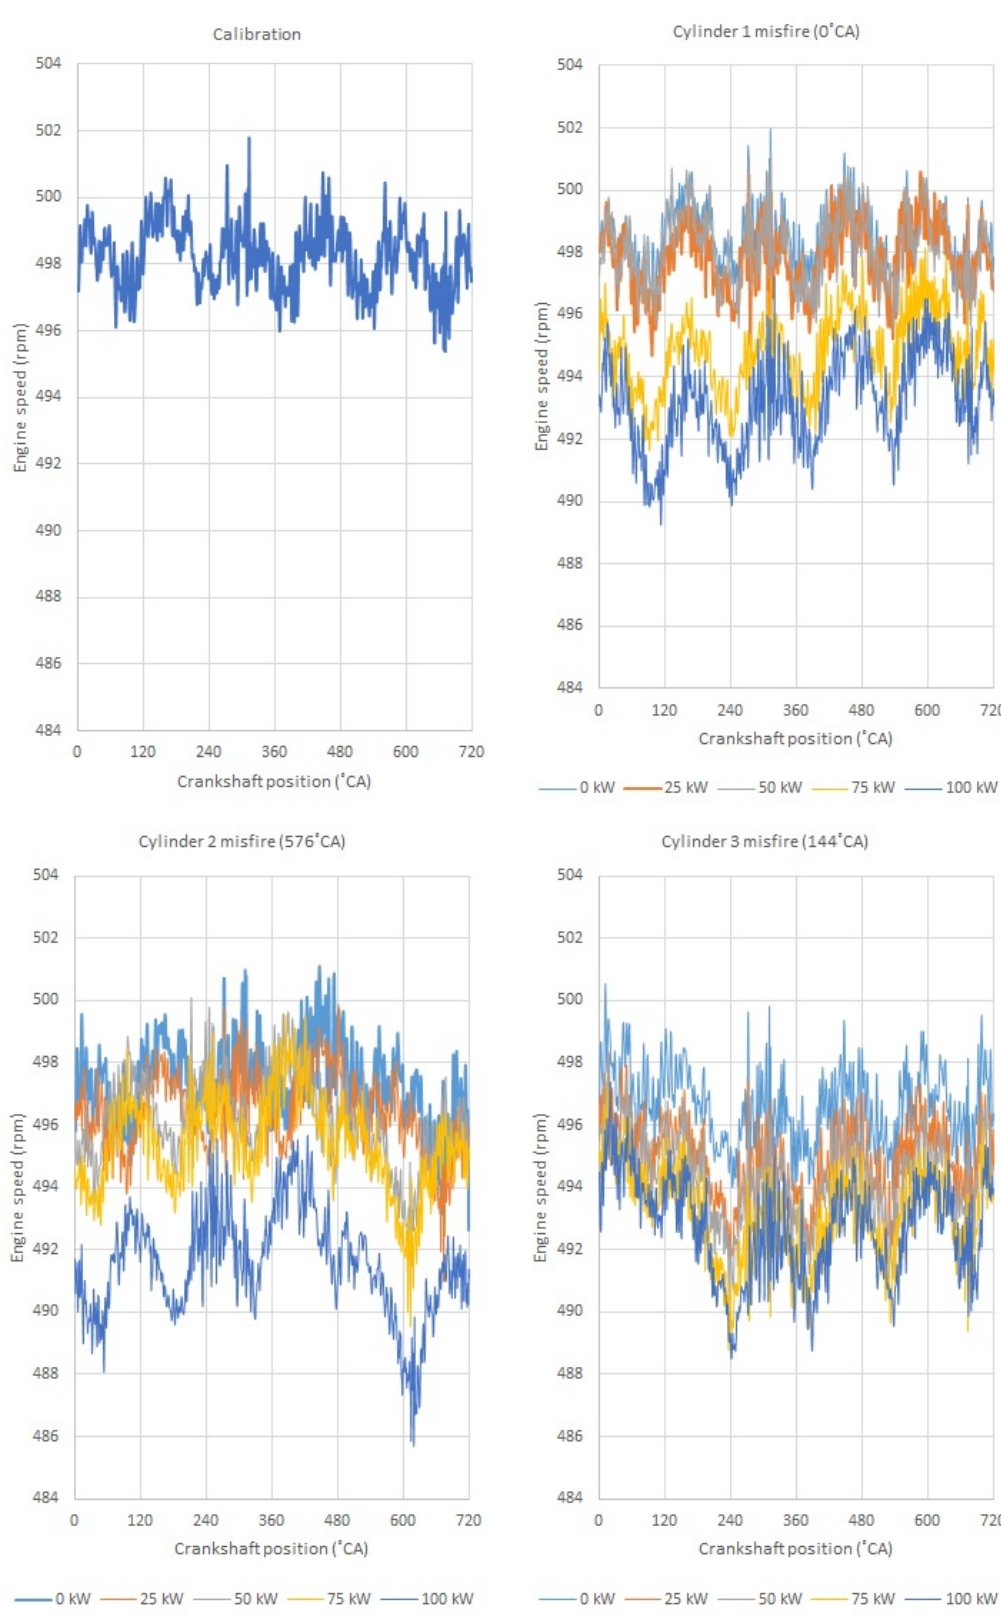
Figure 19. Reference measurement and instantaneous speed cycles at the moment of combustion loss in cylinders 1–3 of Sulzer 5 BAH 22 engine for pre-set electric loads of 0–100 kW .